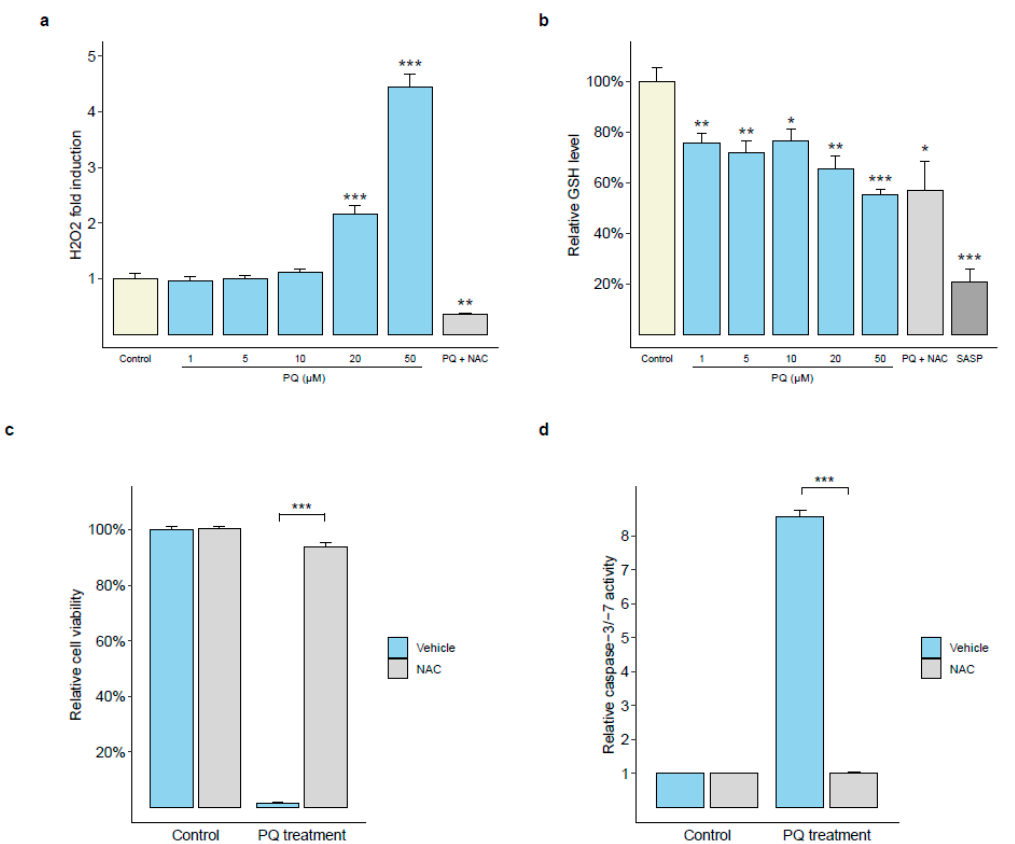
Figure 3. PQ induced cytotoxicity and apoptosis through ROS-dependent manner in PEL cell line. ( a , b ) PQ treatment induced oxidative stress in PEL cell line. BC-3 cells were incubated with increasing concentrations of PQ (1, 5, 10, 20, and 50 µ M) for 24 h, then H 2 O 2 and GSH were quantified using H2- DCFDA and monochlorobimane, respectively, and spectrofluorimetry. Some cells were pre-treated with 3 mM antioxidant N -acetylcysteine (NAC) for 12 h before incubation with 10 µ M PQ. In total, 0.25 mM sulfasalazine (SASP), as a reducer of intracellular GSH levels, was used as a positive control. The GSH and H 2 O 2 levels of untreated cells were defined as 100% (control) and as 1.0 (control), respectively. Values are expressed as mean normalized to H 2 O 2 and GSH levels for the untreated control cells, respectively. Error bars represent the S.E.M of at least triplicates. *, p < 0.05; **, p < 0.01; ***, p < 0.001 vs. untreated control (Welch’s t -test). ( c , d ) The protective effect of antioxidant NAC on cytotoxic and apoptotic effects of PQ. BC-3 cells were pre-treated with (NAC) or without (vehicle) 3 mM NAC for 12 h before treatment with 10 µ M PQ. Cell viability was assessed after 48 h of PQ treatment. The viability of PQ-untreated cells was defined as 100% (control). Caspase-3/-7 activity was evaluated after 24 h of PQ treatment. The caspase activity in PQ-untreated cells was defined as 1.0 relative light unit (control). Values are expressed as mean relative to the control. Error bars represent the S.E.M of triplicate cultures for three independent experiments. ***, p < 0.001 vs. PQ-treated vehicle group (Welch’s t